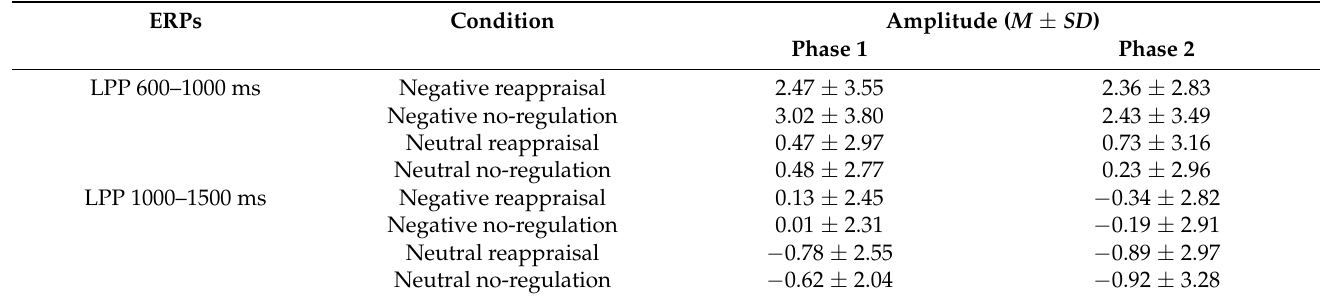
Table 3. Average Amplitudes of Different Components between Different Conditions.